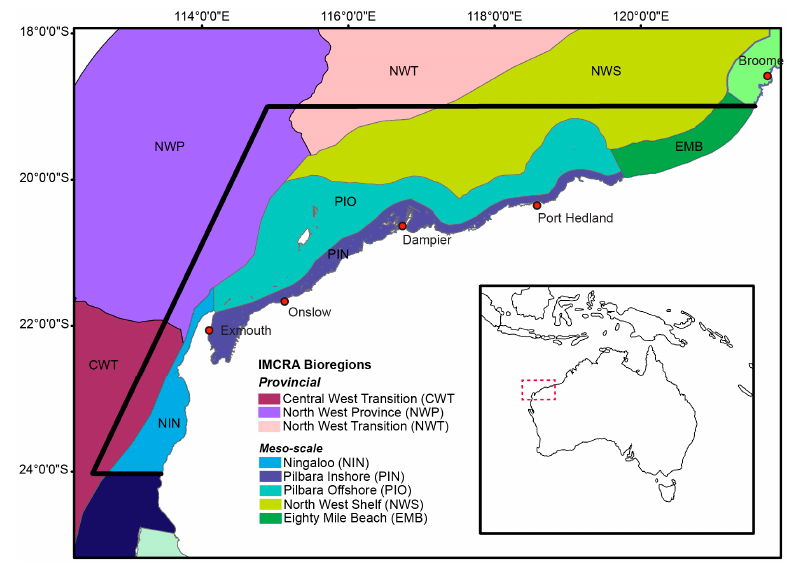
Figure 1. Overview map of the study area within the Pilbara region, northwestern Australia, showing the areas designated for Integrated Marine and Coastal Regionalisation for Australia (IMCRA), with three provincial and five meso-scale bioregions, and associated abbreviations. The black line represents the boundary for the present study.